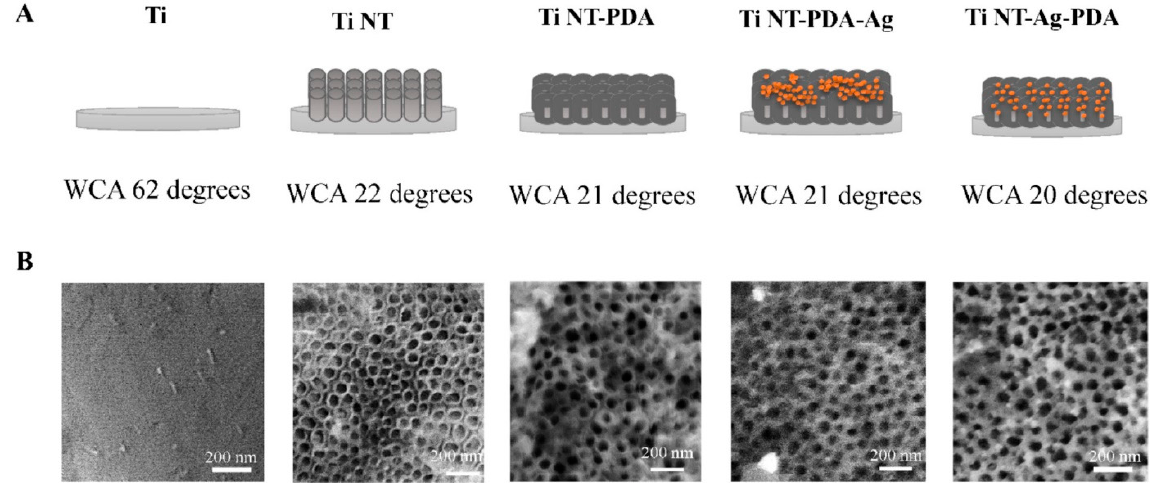
Figure 5. Physicochemical characterization of different, AgNP loaded nanotubular titanium surfaces. ( A ) schematics of the different nanotubular Ti surfaces and their water contact angles (WCA); ( B ) SEM micrographs of the different titanium surfaces with and without nanotubules. The bright spots in the SEM of Ti NTPDA-Ag represent AgNPs. Reprinted with permission from [50] under a Creative Commons license. Table 3. Titanium nanotubes filled with AgNPs showed appropriate antibacterial activity against Gram-positive and Gram-negative